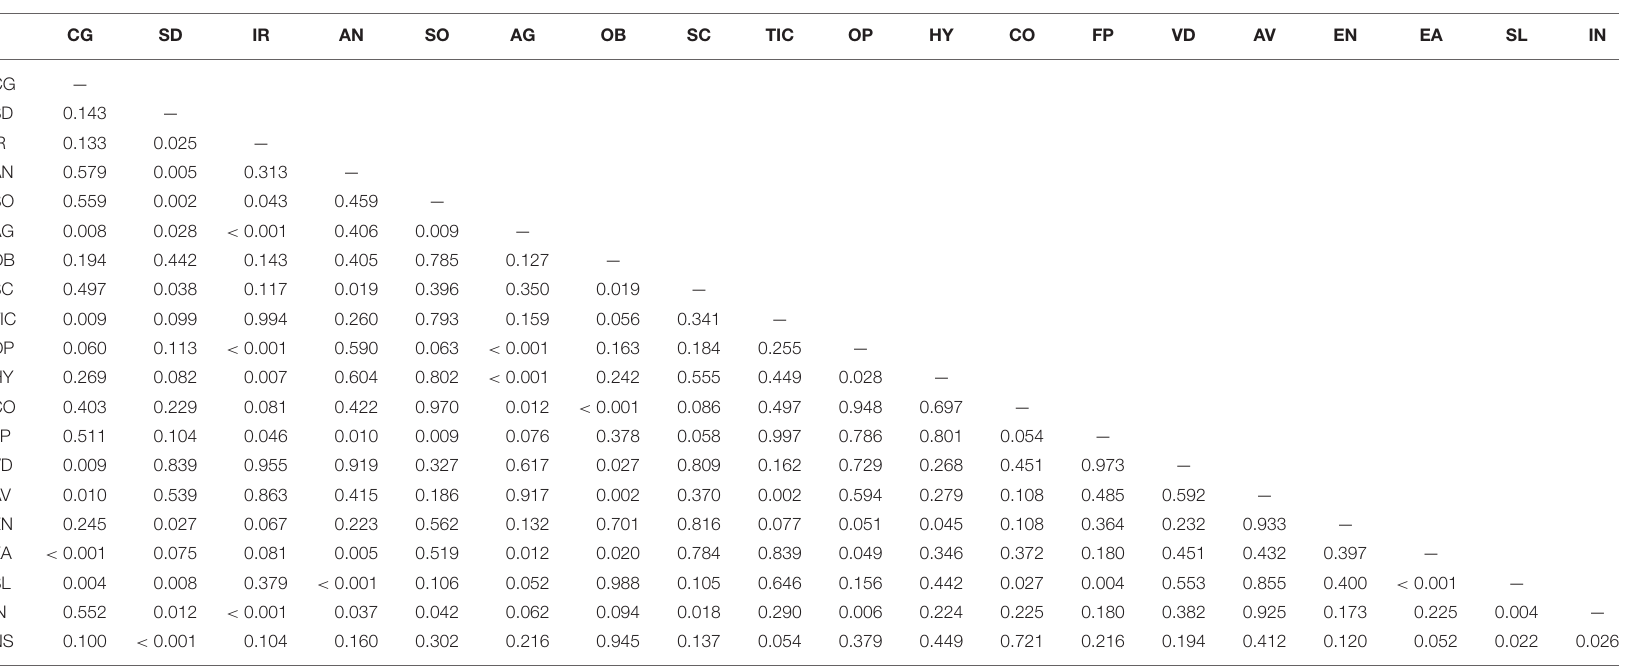
TABLE 5 | Correlation matrix: symptoms- symptoms increased- new